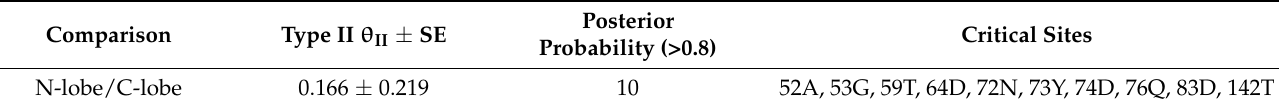
Table 3. Type II functional divergence between the N-lobe and the C-lobe of fish transferrin gene family. The critical sites are displayed by residues on the